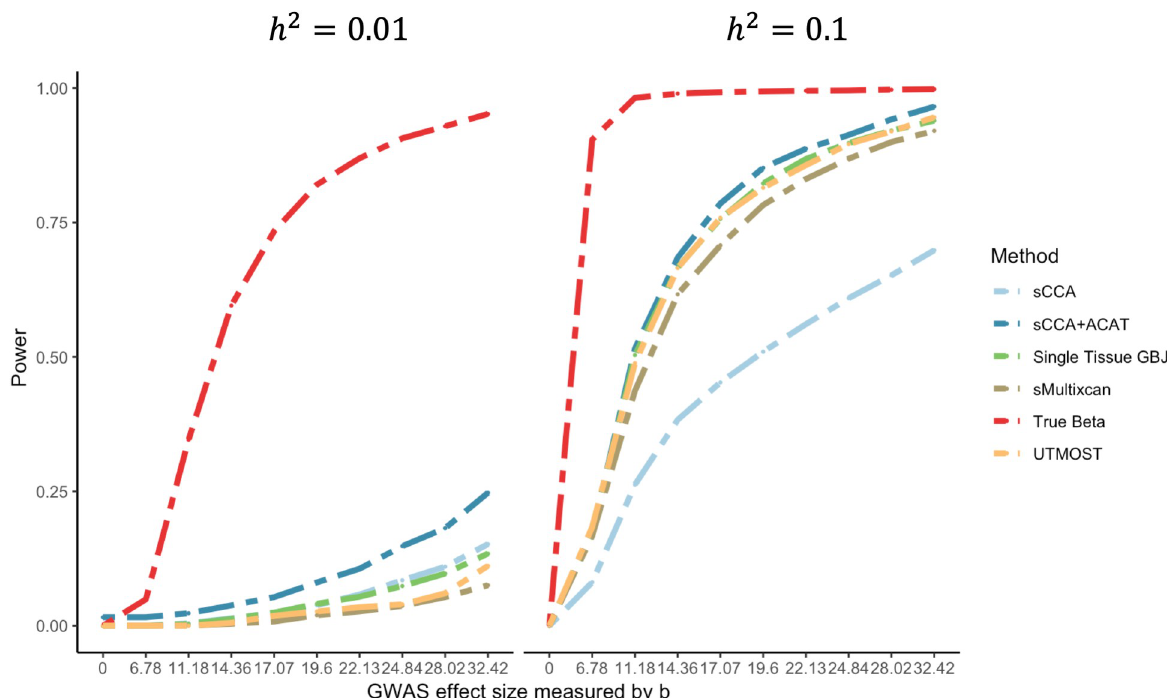
Fig 3. Power comparison for cross-tissue TWAS methods. Power (at α = 2.5 × 10 − 5 ) as a function of GWAS effect size. For each tissue, we ffiffiffiffiffiffiffiffiffiffiffiffiffiffiffiffiffiffiffi p randomly sampled the z-scores from this multivariate normal and set b ¼ to 0.00, 6.78, 11.18, 14.36, 17.07, 19.60, 22.13, 24.84, 28.02, � r 2 N gwas 32.42 to achieve theoretical power of 5%, 10%, ... , 90% at alpha level of 0.05. That is, when r 2 = 1% (when variation in gene expression in the target tissue explains 1% of the variability in the trait), the GWAS sample size N gwas ranges from 4,602 to 105,074. h 2 denotes the proportion of expression variance in the causal tissue explained by cis-genetic variation. sCCA+ACAT: combining 3 sCCA-features and 22 single-tissue tests with ACAT; sCCA: combining top 3 sCCA-features tests using a Bonferroni correction; Single Tissue_GBJ: combining 22 single-tissue TWAS statistics using the GBJ test; s-MultiXcan: combining 22 single tissue based test using s-MultiXcan); UTMOST: single tissue based approach with UTMOST; true weights: a TWAS test using the true (simulated) weights relating SNPs to expression in the causal tissue.